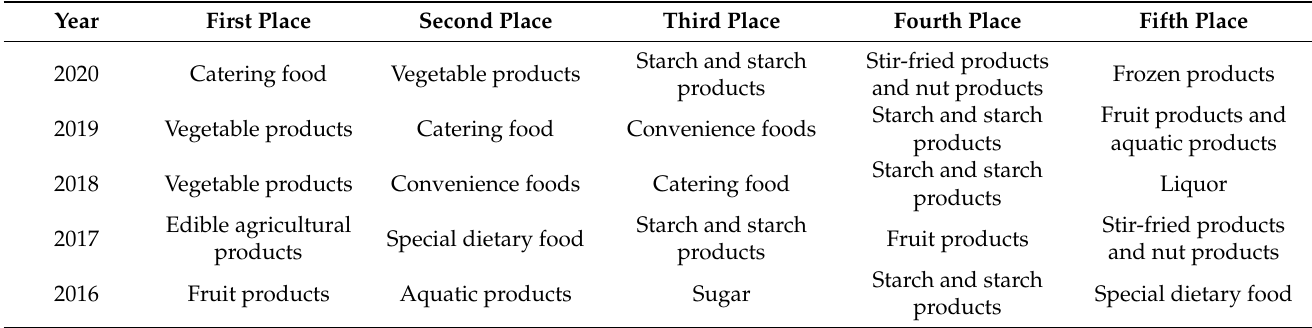
Table 4. High-risk categories in the national food safety inspection from 2016 to